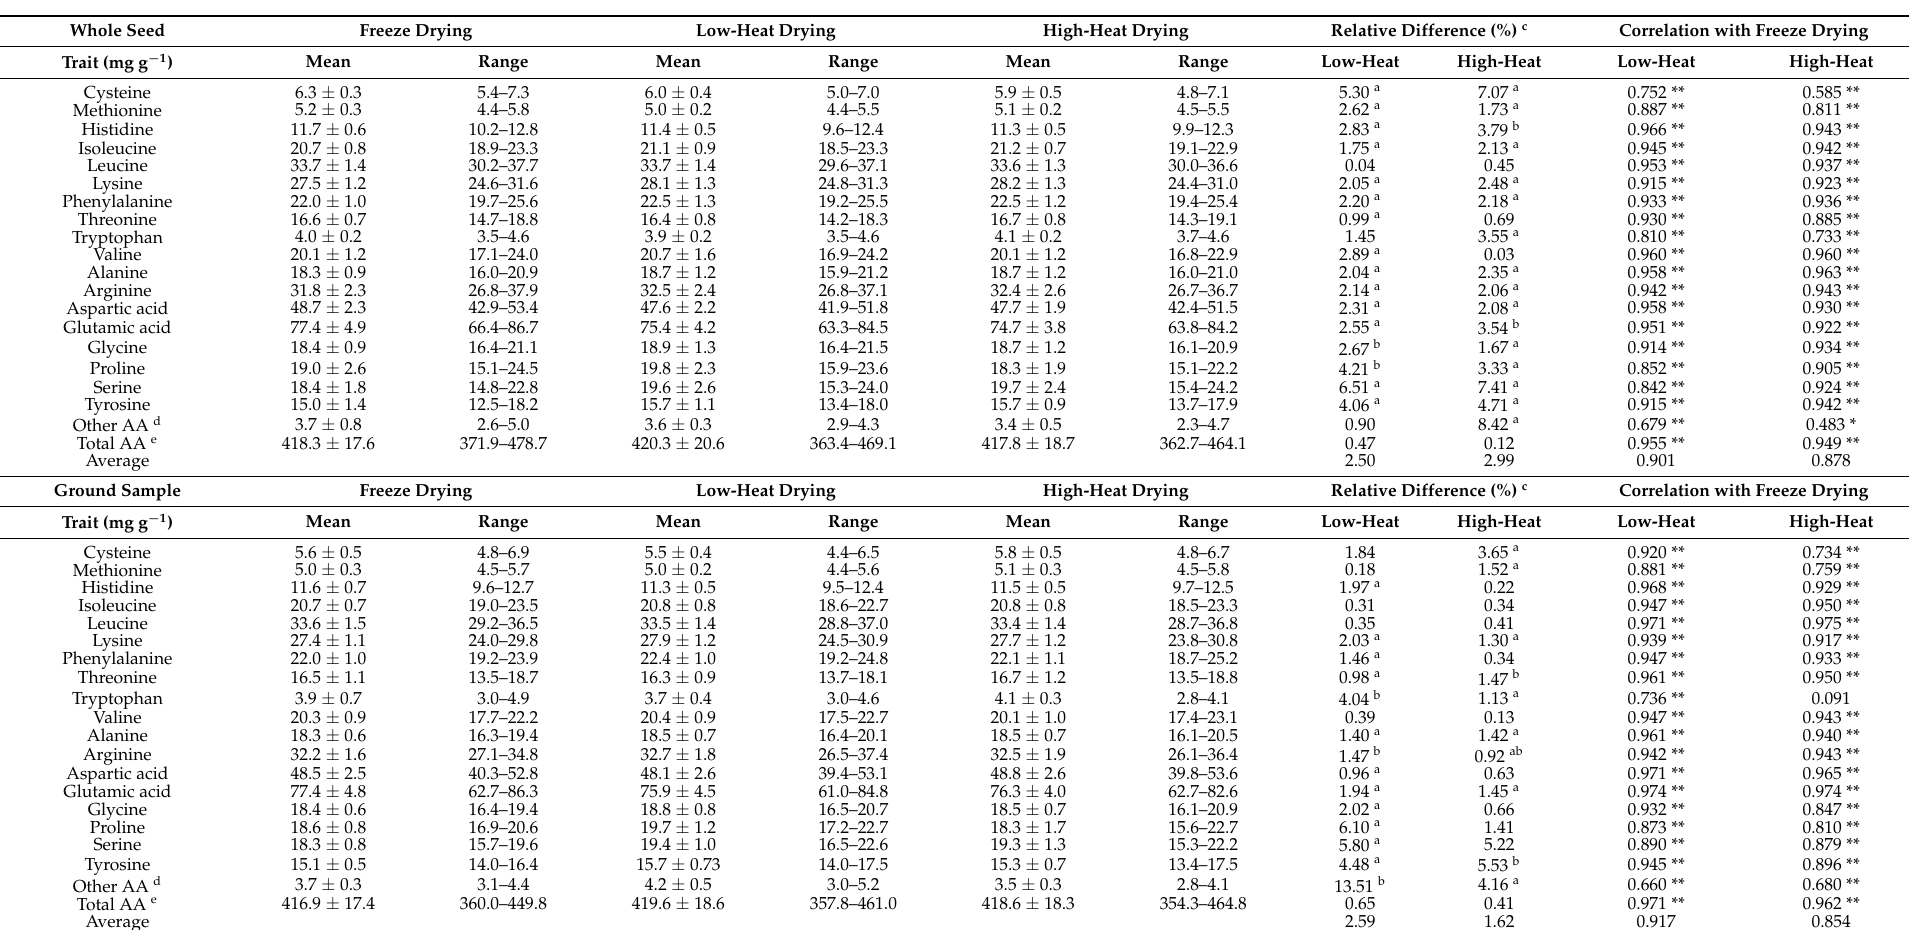
Table 6. Means ( ± SD) and ranges of variation of seed amino acid traits in fresh edamame dried by freeze, low-heat and high-heat drying methods, and correlations between heat drying and freeze drying with whole seed and ground samples over three years